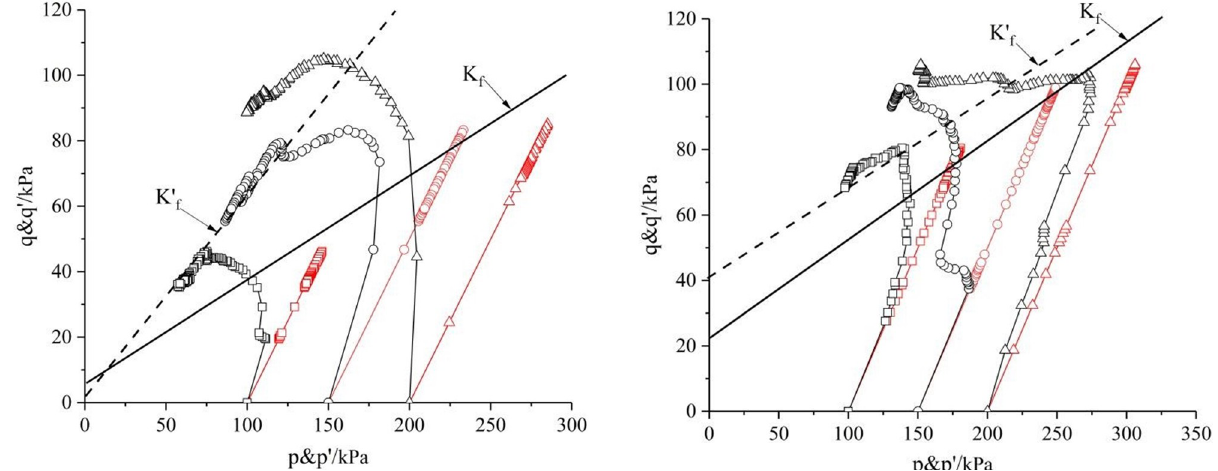
Fig 8. p~q curve with ρ